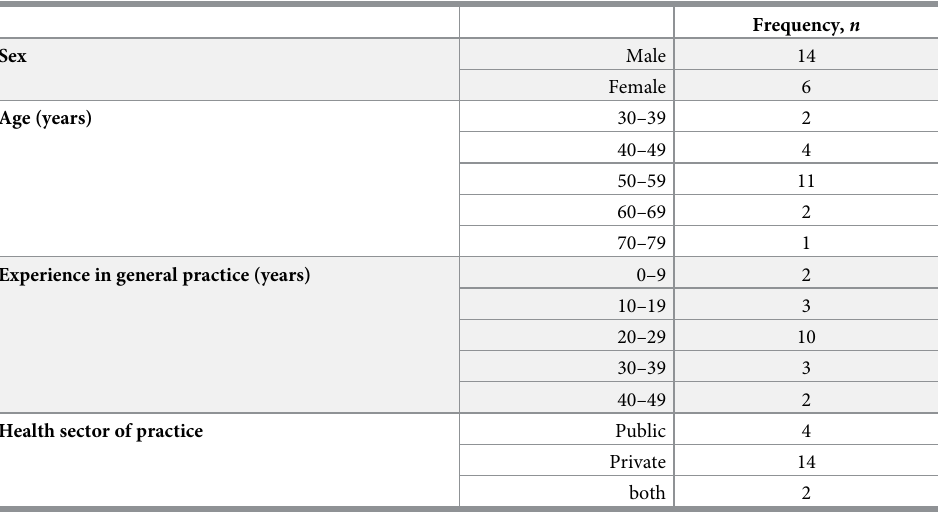
Table 1. General practitioners’ demographic characteristics (n =